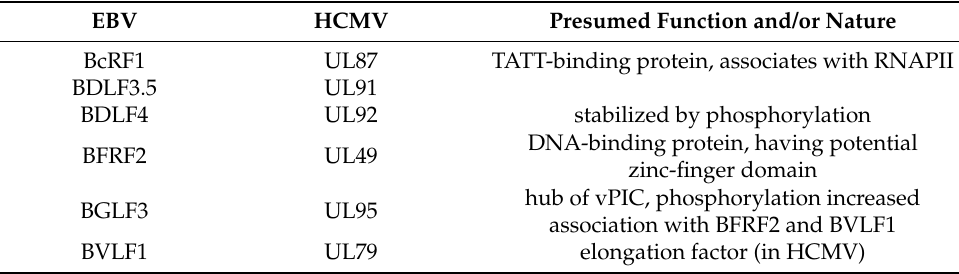
Table 4. vPIC genes of EBV, KSHV, and